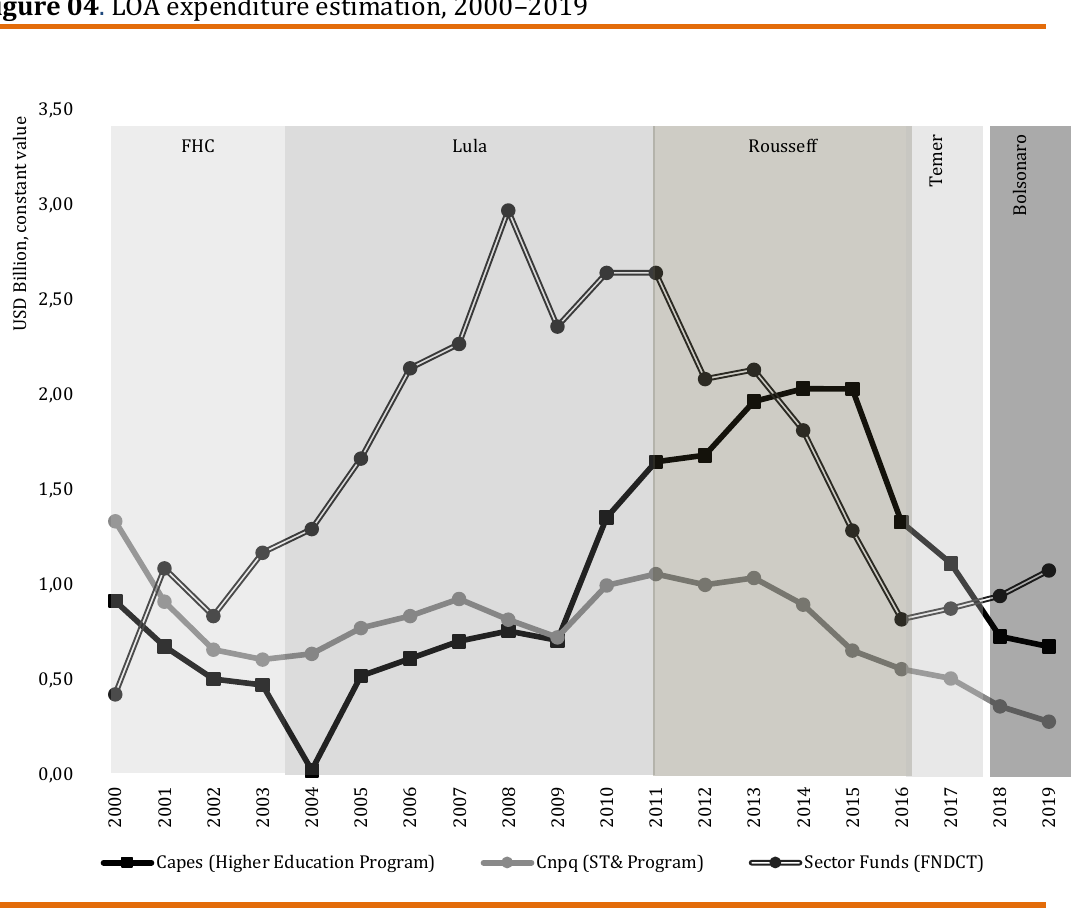
Figure 04 . LOA expenditure estimation, 2000 –